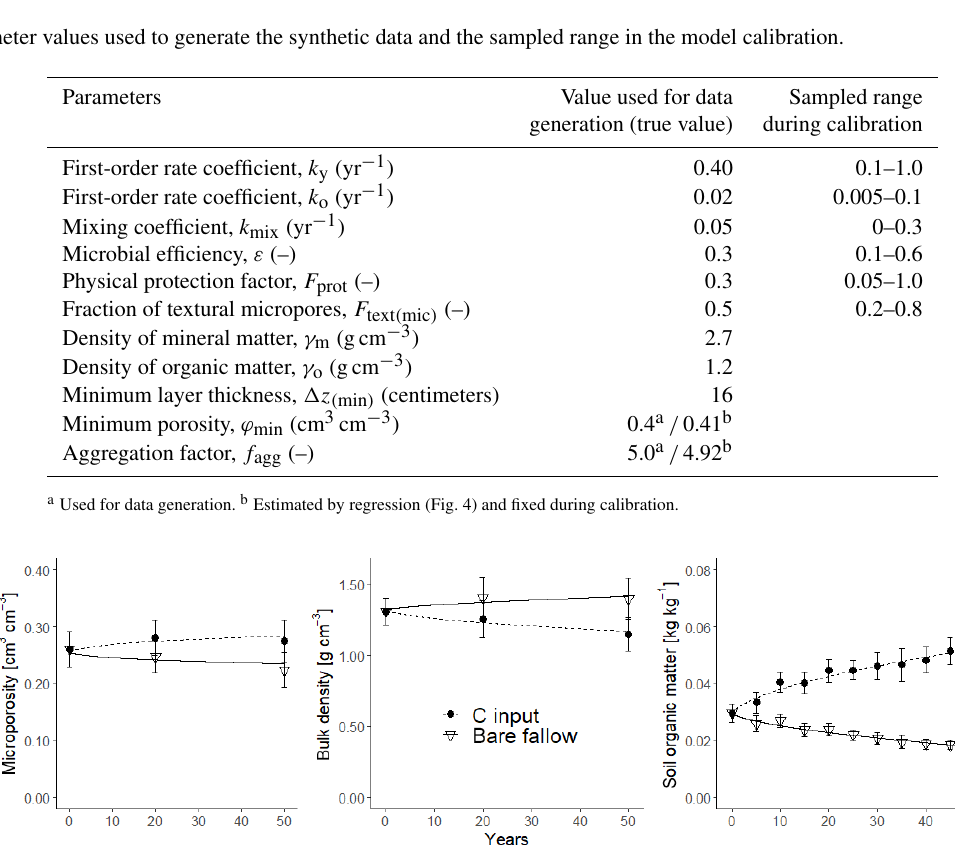
Figure 6. Synthetic data (symbols; bars show standard deviations) for microporosity, bulk density and soil organic matter concentration and model simulations (lines) after calibration.